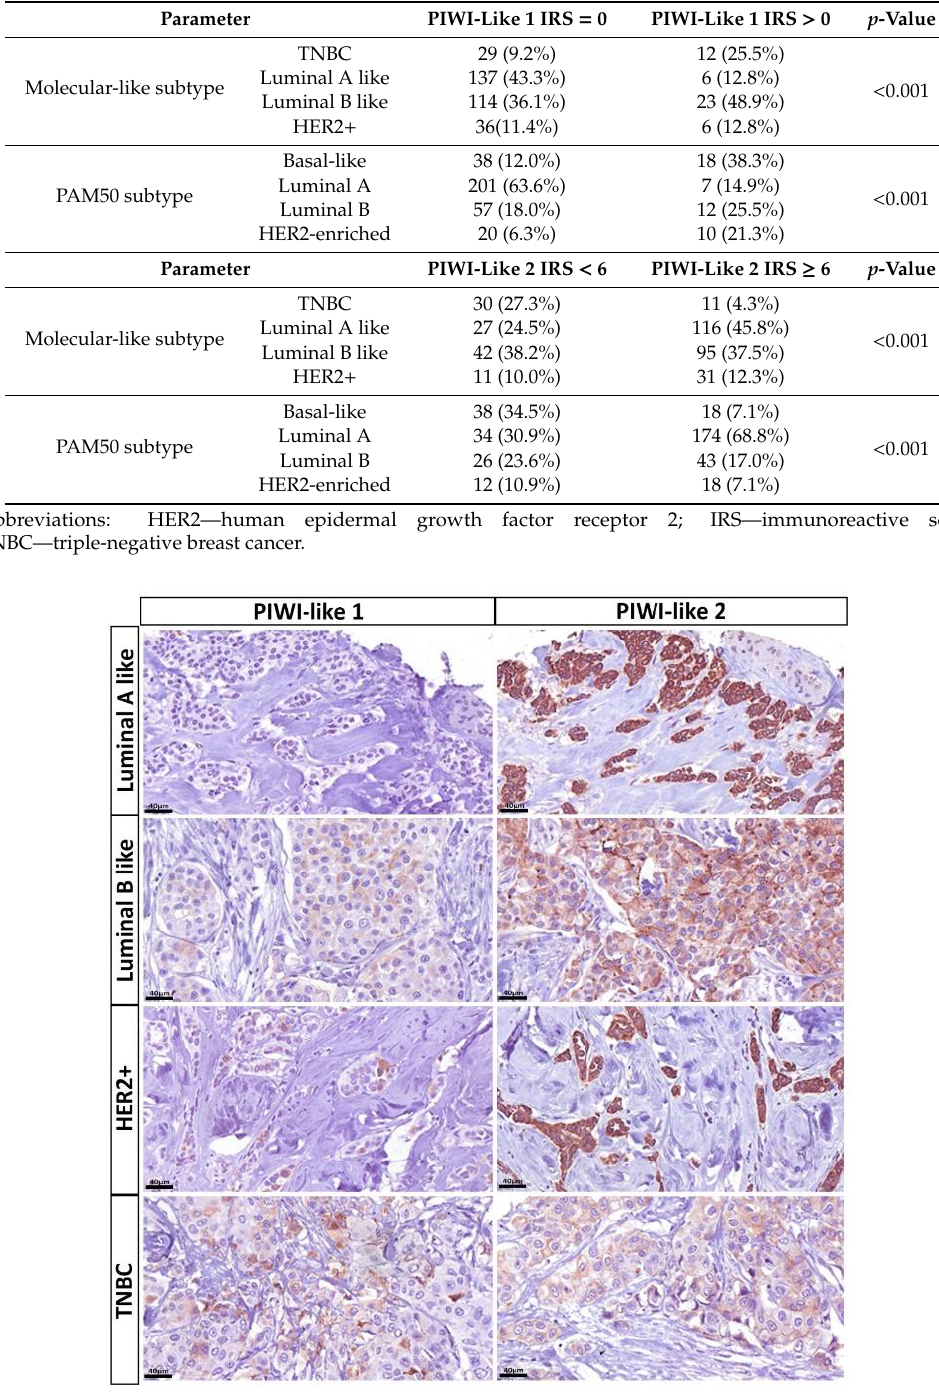
Figure 7. Immunohistochemical (IHC) expression patterns of PIWI-like 1 and PIWI-like 2 varied within the molecular-like (IHC) subtypes: tumors presented typically without PIWI-like 1 (IRS 0 / 12), but with strong and homogenous PIWI-like 2 expression (IRS 12 / 12). In contrast, Luminal B-like and HER2 + breast cancer cases depicted a slight expression of PIWI-like 1 in some tumor cells (IRS 2 / 12 and 4 / 12, respectively) with moderate or strong PIWI-like 2 staining (IRS 6 / 12 and 12 / 12, respectively). Triple-negative breast cancer (TNBC) showed increased PIWI-like 1 (IRS 4 / 12) and decreased PIWI-like 2 expression (IRS 3 / 12) when compared with Luminal A-like